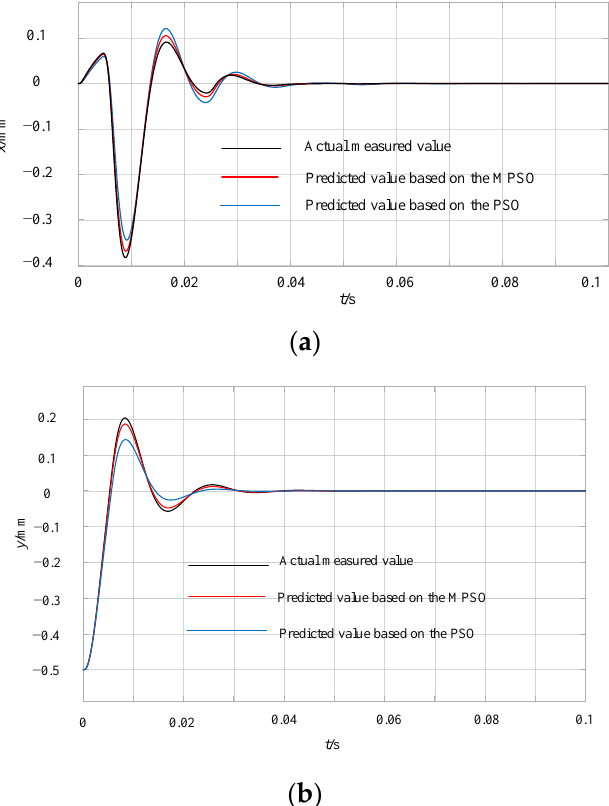
Figure 6. The displacement prediction curves of the rotor of the six-pole hybrid magnetic bearing: ( a ) in the x direction; ( b ) in the y direction.